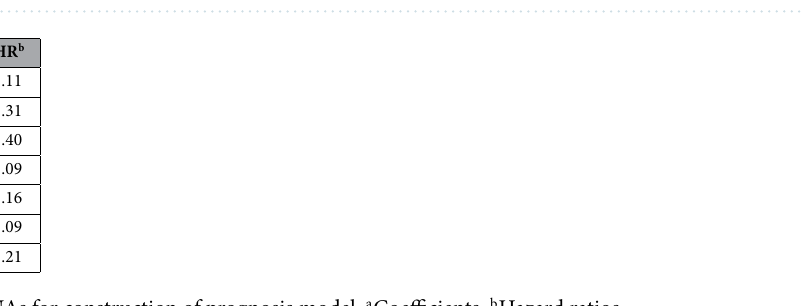
Figure 2. Identification of the prognosis-related lncRNAs. ( A&B) LASSO coefficient profiles; ( C ) Multivariate cox analysis of seven model lncRNAs; ( D ) The Kaplan–Meier curves of AC073611.1; ( E) The Kaplan–Meier curves of AC027307.2; ( F ) The Kaplan–Meier curves of AC156455.1; ( G ) The Kaplan–Meier curves of PCAT6; ( H ) The Kaplan–Meier curves of AL161729.4; ( I ) The Kaplan–Meier curves of LINC01063; ( J ) The Kaplan– Meier curves of MIR210HG.